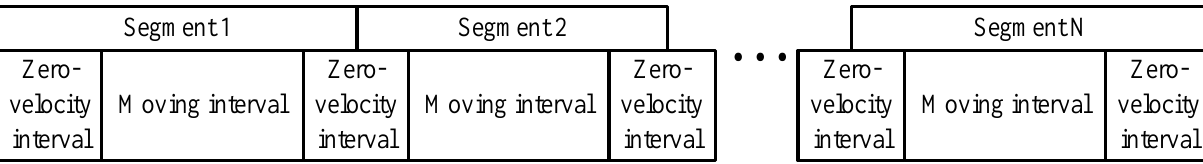
Figure 5. A movement with multiple zero velocity